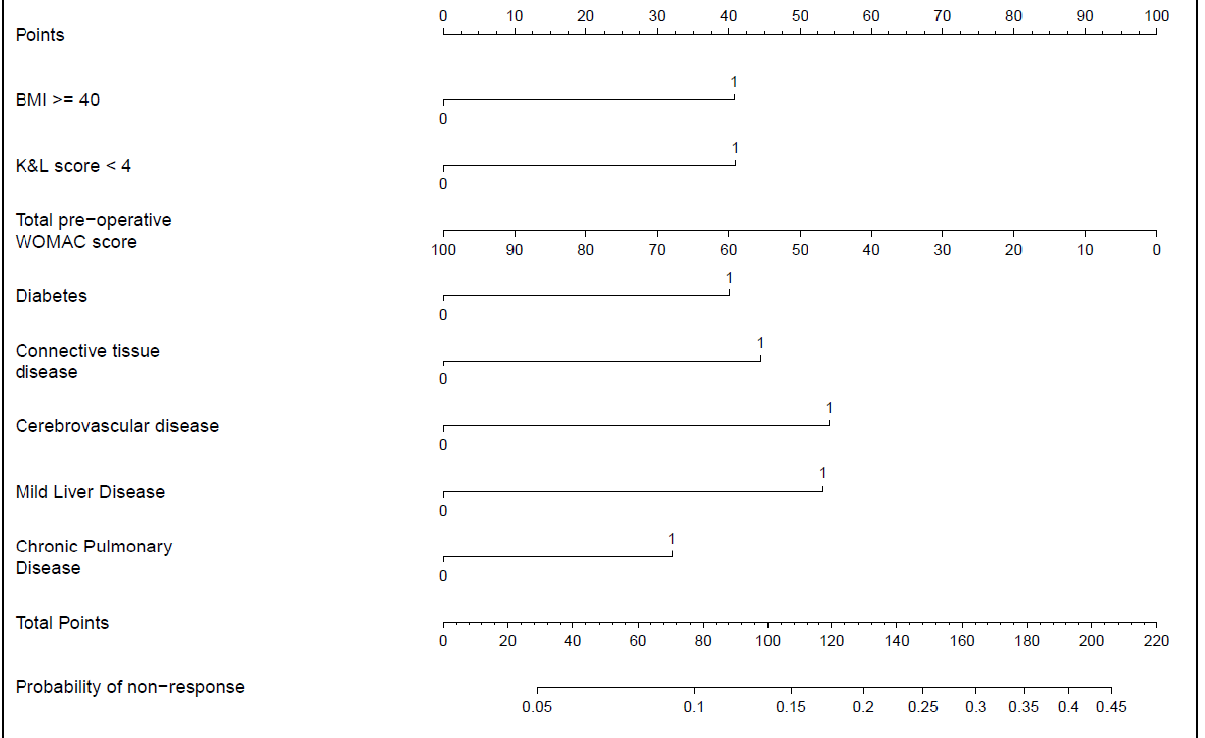
Figure 1. Nomogram for non-response to THR.